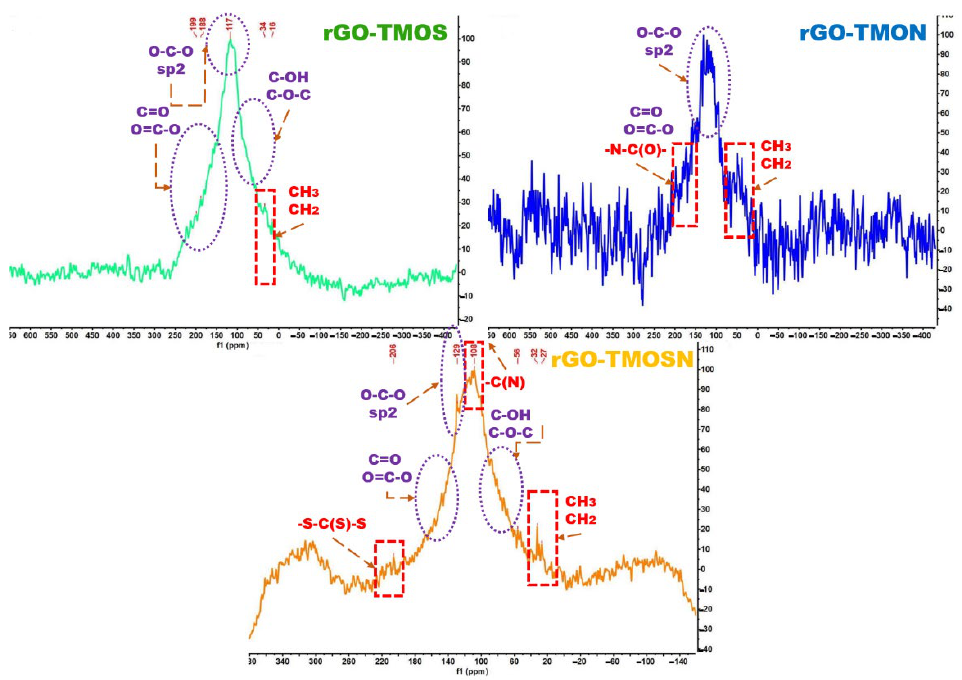
Figure 3. 13 C-NMR results for reduced graphene oxide monolith rGO60_0.5 modified with TMOS or TMON or TMOSN.